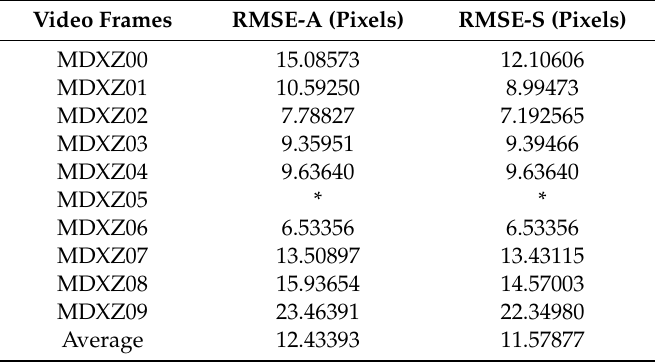
Table 2. Experimental results on dataset MDXZ. Quantitative comparisons on di ff erent matching strategies using the root of mean square error (RMSE).